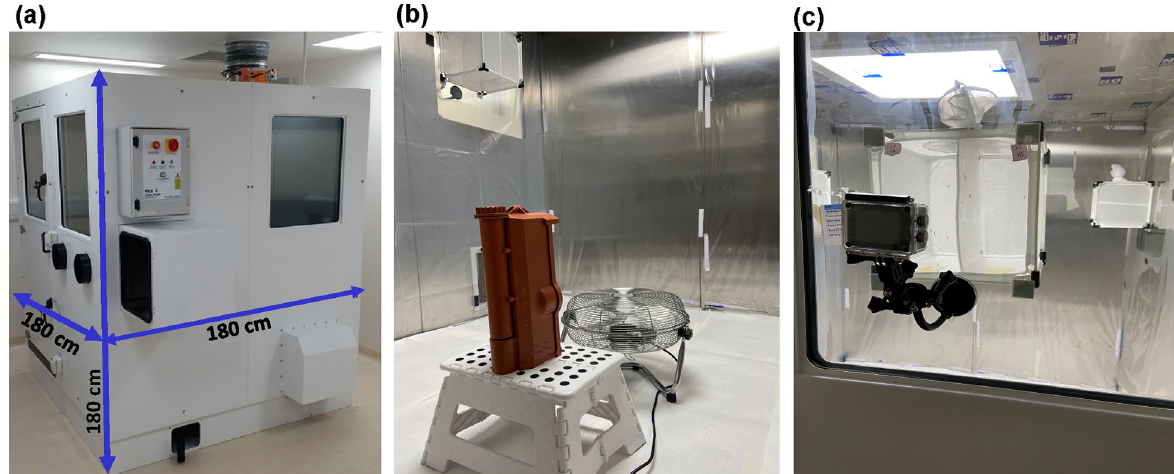
Figure 1. Peet-Grady chamber’s external and internal overview. ( a ) Chamber lateral profile showing glass observation windows, electrical control panel and extraction duct at the ceiling’s rear. ( b ) Set-up of the automatic aerosol dispenser and a 30-cm diameter fan in the chamber centre. ( c ) View through a chamber’s glass observation window with a camera to assist with the scoring of mosquito